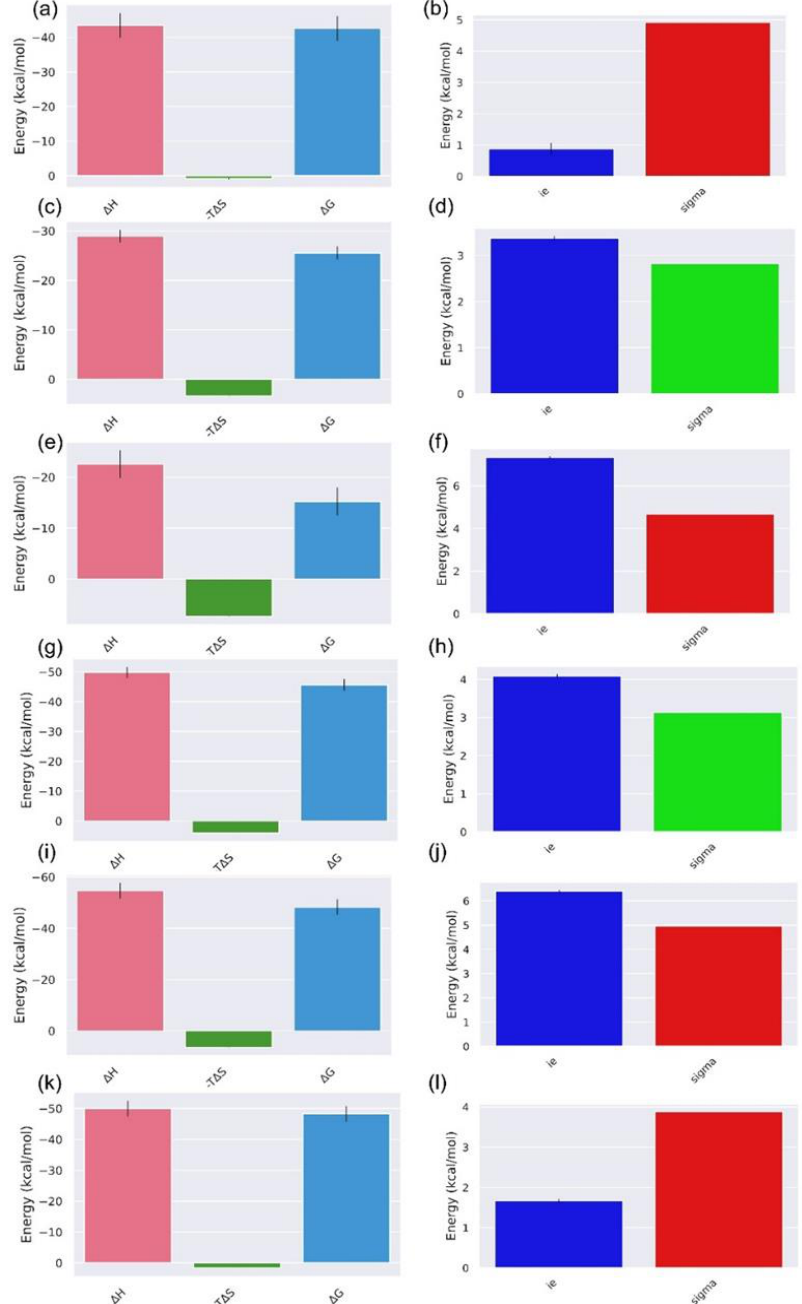
Figure 5. Enthalpy (ΔH), Entropy (TΔS), Binding free energy (ΔG), Interaction Entropy (IE), and Sigma (standard deviation of the interaction energy) values for compounds ( a , b ) Catechin 3,7,-Di- O -Galate, ( c , d ) Catechin 5,7,-Di- O -Gallate, ( e , f ) Catechin 5,4’ -Di- O -Gallate, ( g , h ) Epifisetinidol- (4beta->8)-Catechin, ( i , j ) Catechin 3- O -Rutinoside, ( k , l ) Epicatechin (4b->6) Catechin complex with CYP121 protein.